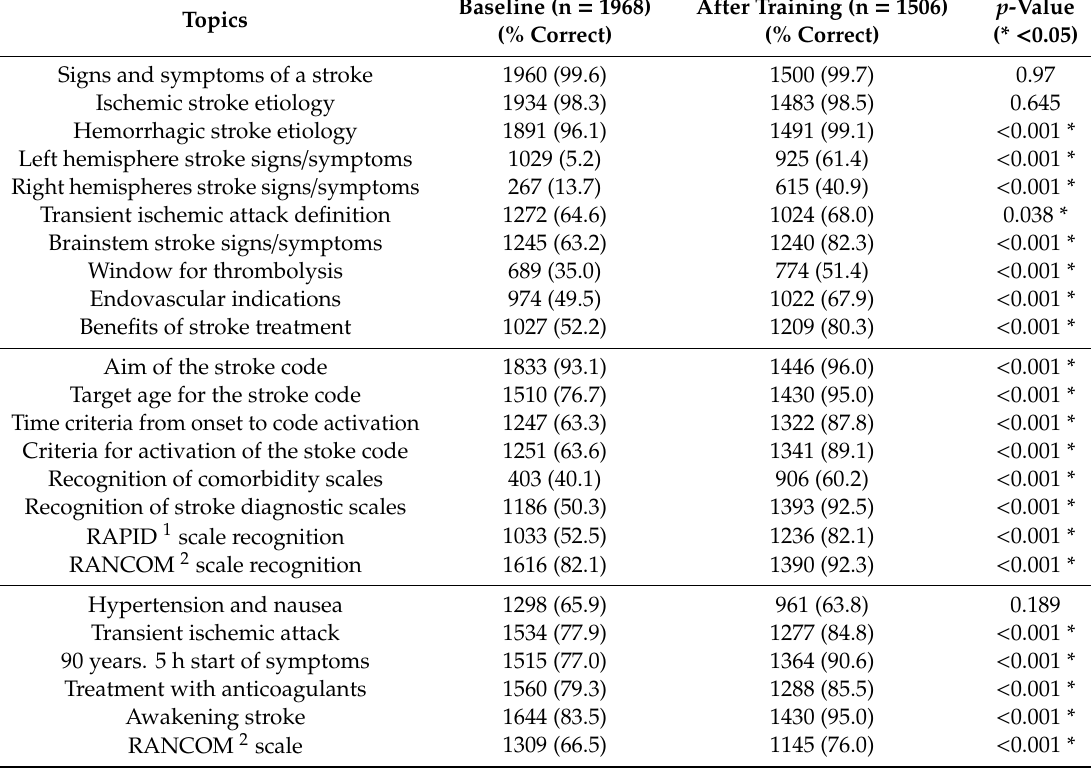
Table 1. Di ff erences in the responses to the knowledge multiple-choice